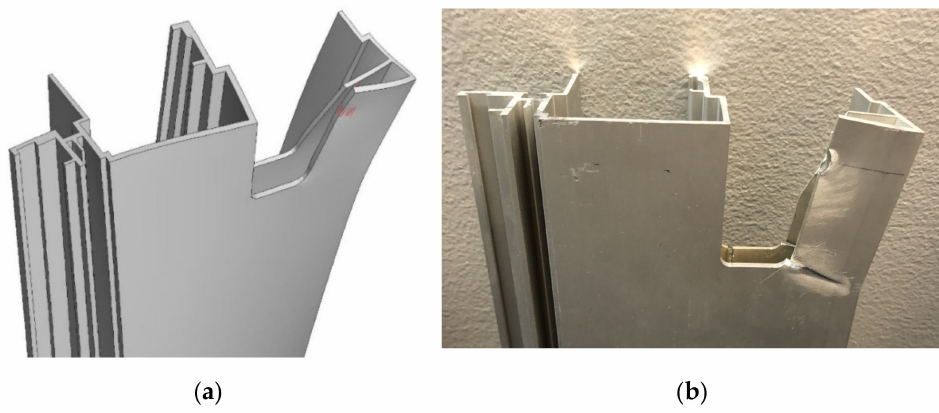
Figure 16. Deformed shape of the specimen N1: ( a ) numerically and ( b ) experimentally obtained. The highest achieved force for models using the true stress–strain curve was 5.5 kN, and the highest achieved force for models using the standardised stress–strain curve (alloy EN AW 6063 T6) was 5.0 kN. Models of the semi-circular notch at 67.5 mm achieved 0.5 kN less force: 5.0 kN and 4.5 kN. The distribution of the strain for all models is shown in Figures 17–20. The wide area of the yielding can be seen (magenta) around the root of the notch.